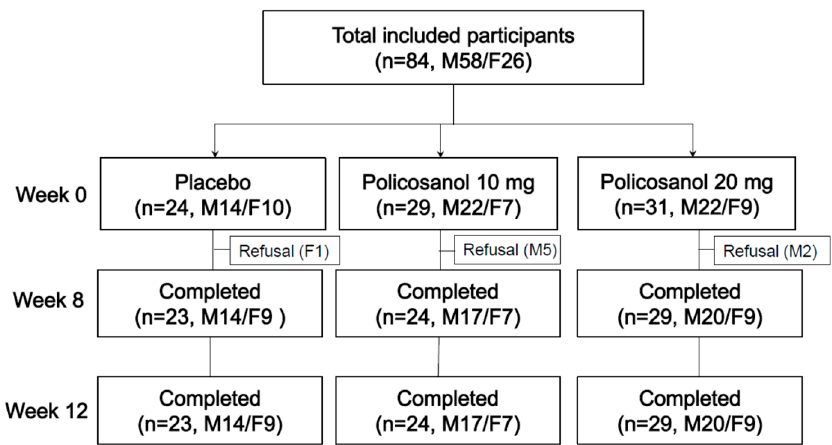
Figure 1. Design of study and participants. Inclusion criteria were normolipidemic, normoglycemic, and healthy subjects who had prehypertension (systolic 130–139 mmHg, diastolic 80–89 mmHg). M: Male; F: Female.